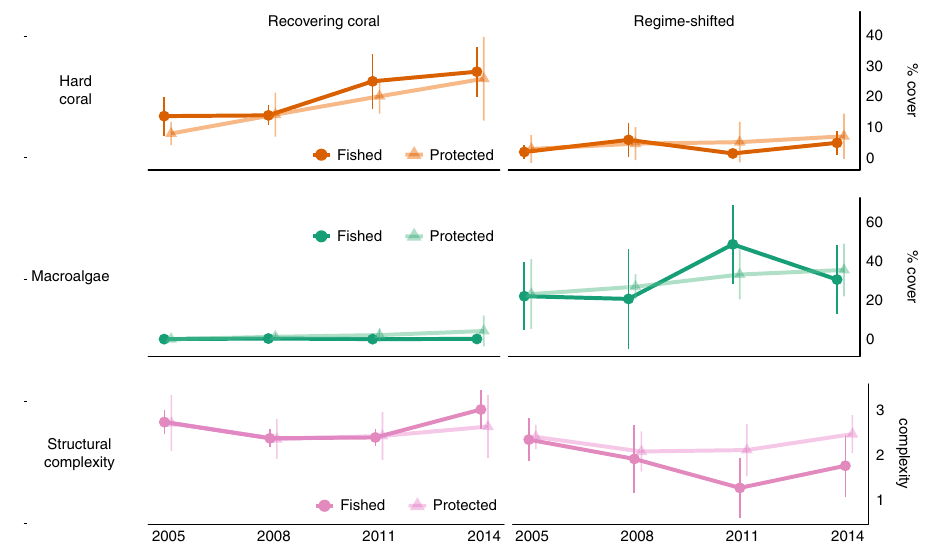
Fig. 2 Change in benthic habitat composition after coral bleaching. Points are mean values (±2 standard error) for percent cover of hard coral (orange) and macroalgae (green), and habitat structural complexity (pink) over 2005 – 2014, for recovering coral (left panel, n = 12) and regime-shifted reefs (right panel, n = 9). Fished reefs are dark-shaded and reserve reefs are light-shaded. Note different y -axis ranges for different benthic taxa. Source data are provided as a Source Data fi